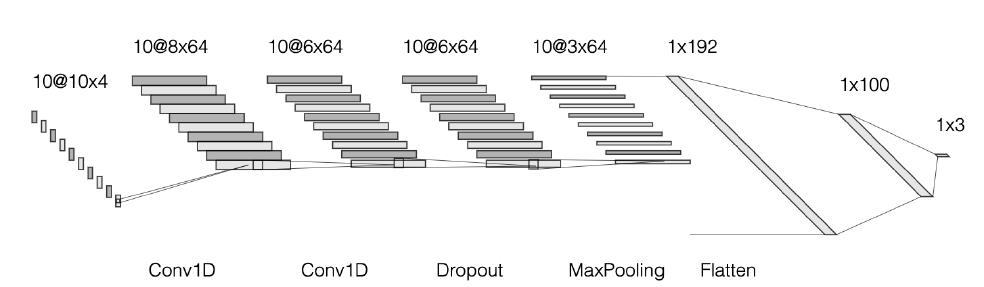
Figure 8. Sequence of layers of a convolutional neural network.